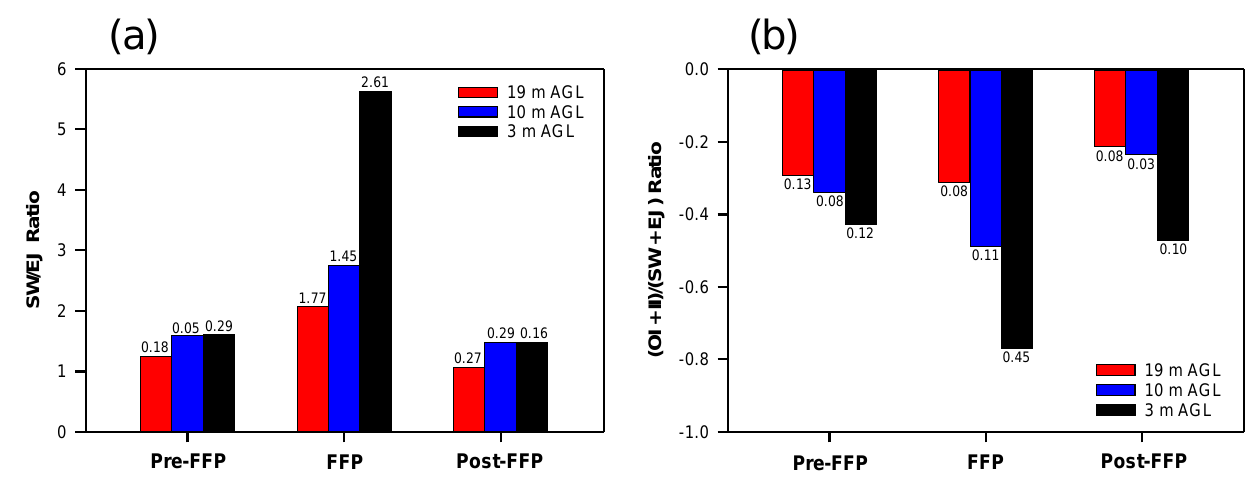
Figure 8. Mean ( a ) sweep (SW)/ejection (EJ) contribution ratios and ( b ) exuberance ((outward interaction (OI) contribution + inward interaction (II) contribution)/(sweep (SW) contribution + ejection (EJ) contribution)) values during the pre-FFP, FFP, and post-FFP periods at 3 m, 10 m, and 19 m AGL, computed from all five in situ towers. Numbers above or below the bars indicate standard deviations.